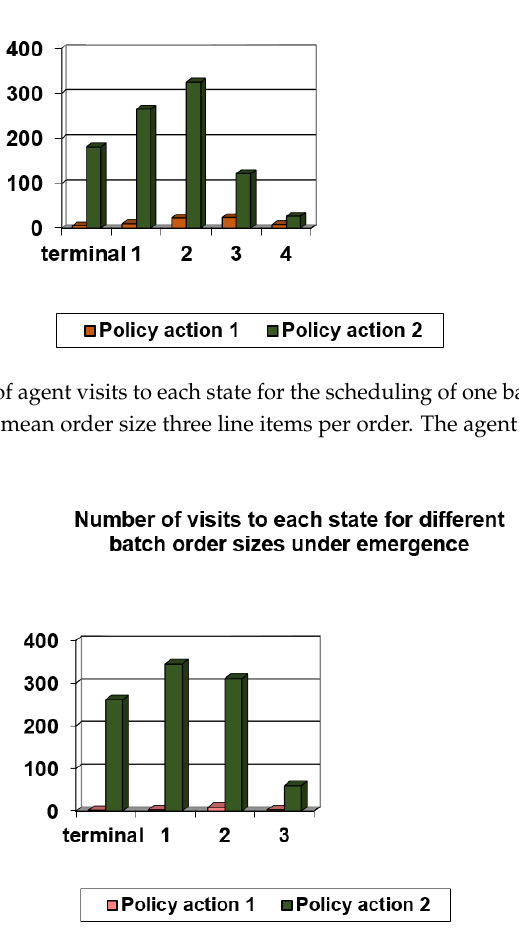
Figure 11. The number of agent visits to each state for the scheduling of one batch of 28 orders and four emergency orders, with mean order size four line items per order. The agent followed a non-ε-greedy policy with ε = 0.